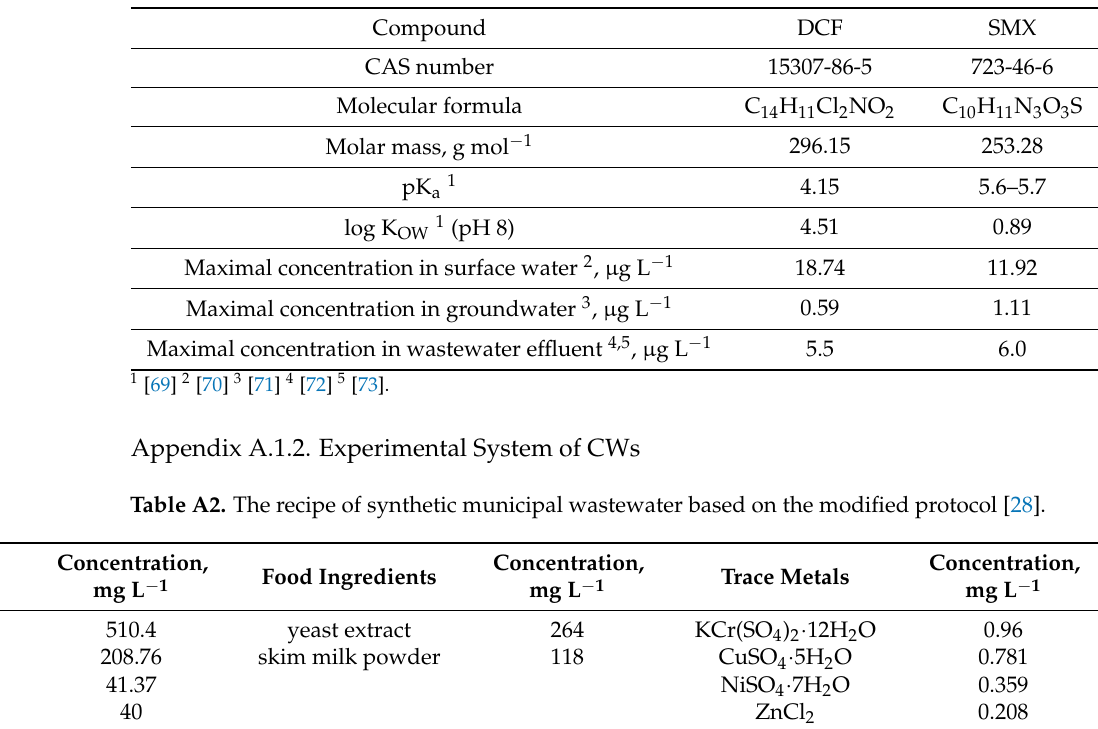
Table A1. Basic properties and concentration of DCF and SMX in wastewater and in the environment.